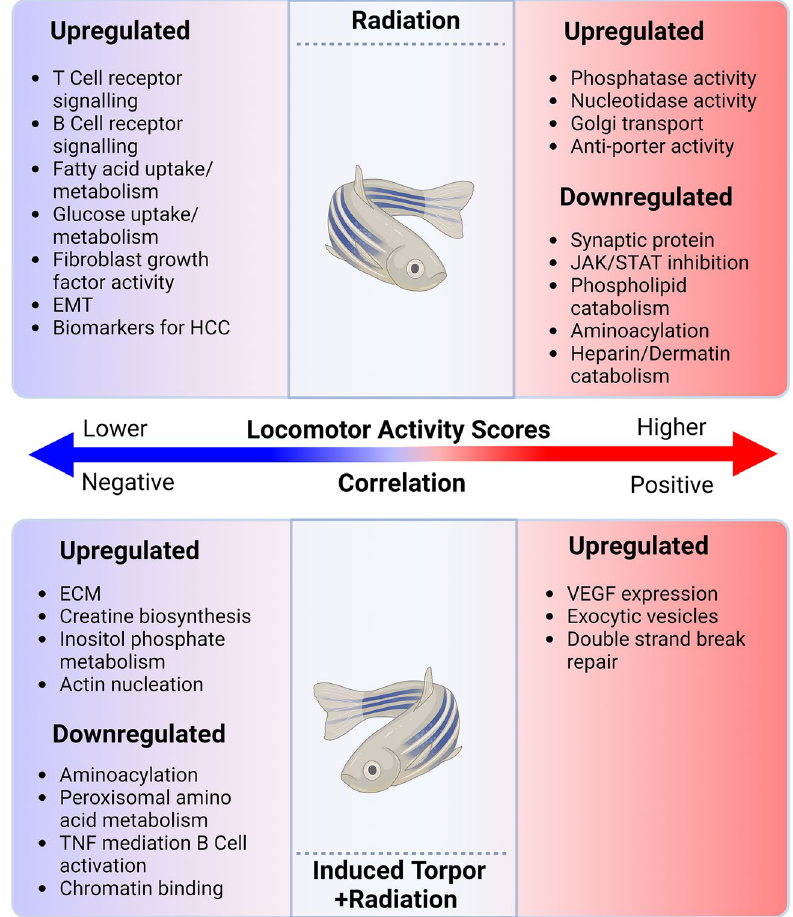
Figure 4. Genes correlated with locomotor activity scores in the radiation and torpor + radiation groups. This schematic shows that increased activity scores in the radiation group are correlated to an upregulation of genes involved in biological processes such as nucelotidase activity, Golgi transport and phagocytosis, and a downregulation of growth, endocytosis, aminoacylation and heparin catabolism related genes. Genes correlated with lower activity scores in the group are associated with immune-related processes such as hemopoiesis, mononuclear cell differentiation, and B cells receptor signalling. In the torpor + radiation group genes correlated with higher activity scores are associated with VEGF expression, exocytic vesicles, and double strand break repair. Genes correlated with decreased activity are correlated with ECM, actin nucleation, creatine biosynthesis and inositol phosphate and a downregulation of genes involved in aminoacylation, amino acid metabolism, B cell receptor activation and chromatin binding. Created with